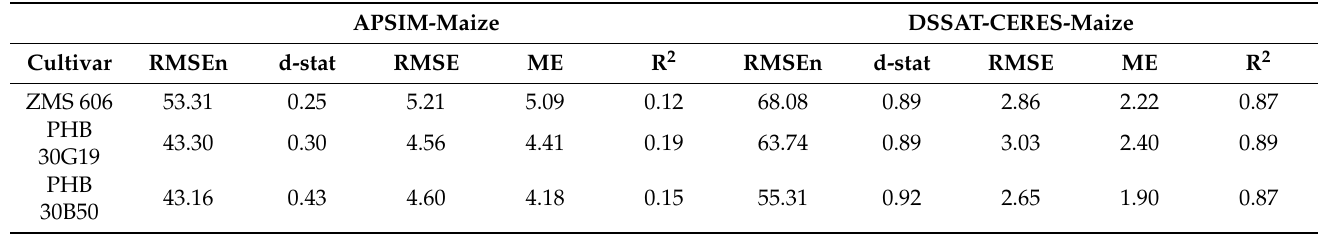
Table 8. The APSIM-Maize and DSSAT-CERES-Maize model calibration statistics for the biomass yield for the maize cultivars under rainfed